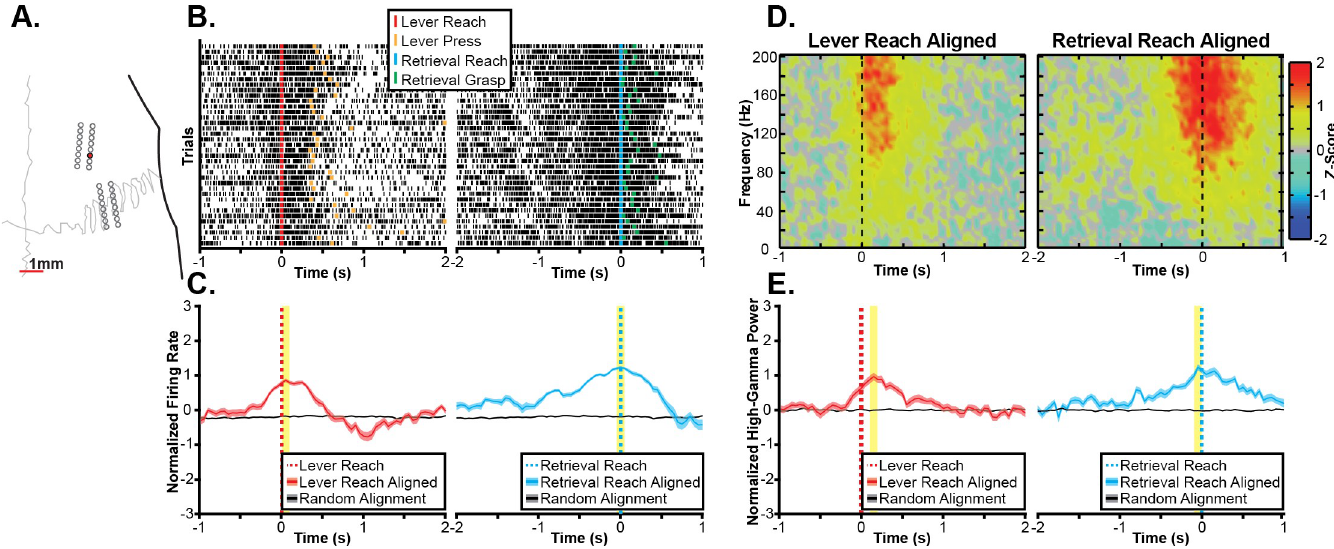
Fig 4. Exemplar reach-related channel. A. Task-related neural activity is shown for an exemplar channel from the RFA array of Rat 1 as shown by the red electrode in the topographic plot. B. Raster plots show multi-unit spike times (black ticks) aligned to the onset of the reaching movement towards the lever (left) and food pellet (right), showing an increase in firing rate correlated to the reach onset. C. Multi-unit firing rates were estimated by counting spike times within 100 ms windows shifted by 50 ms between windows and then averaging firing rates across trials, showing a statistically significant (p < 0.05) increase in firing rate aligned to the onset of the reach in both task components. The statistically significant peak firing rates are indicated by the yellow highlighting. D. Spectral power changes are plotted aligned to the onset of reaching movements to the lever (left) and pellet (right). Spectral power changes were log transformed and z-scored relative to randomly selected time windows between trials, therefore, positive values indicate increases in spectral power, and negative values indicate decreases in spectral power. A broadband increase in spectral power in frequencies above 60Hz was observed for both the reach to the lever and the reach to the pellet. E. High-gamma band (70Hz-110Hz) power was significantly increased around both the reach to the lever (left) and the reach to the food pellet (right). The statistically significant peak modulations of high-gamma band spectral power are indicated by the yellow